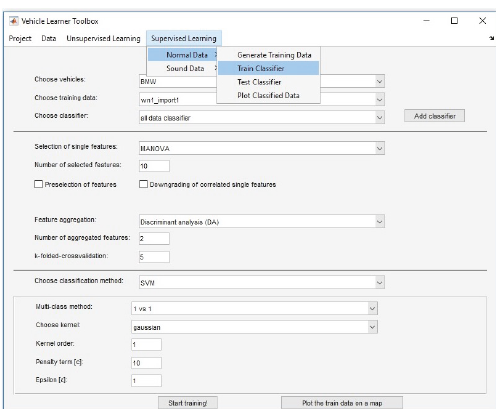
Figure 4: The train classifier frame of the Vehicle Learner Toolbox . Multiple classifiers can be trained with a wide range of